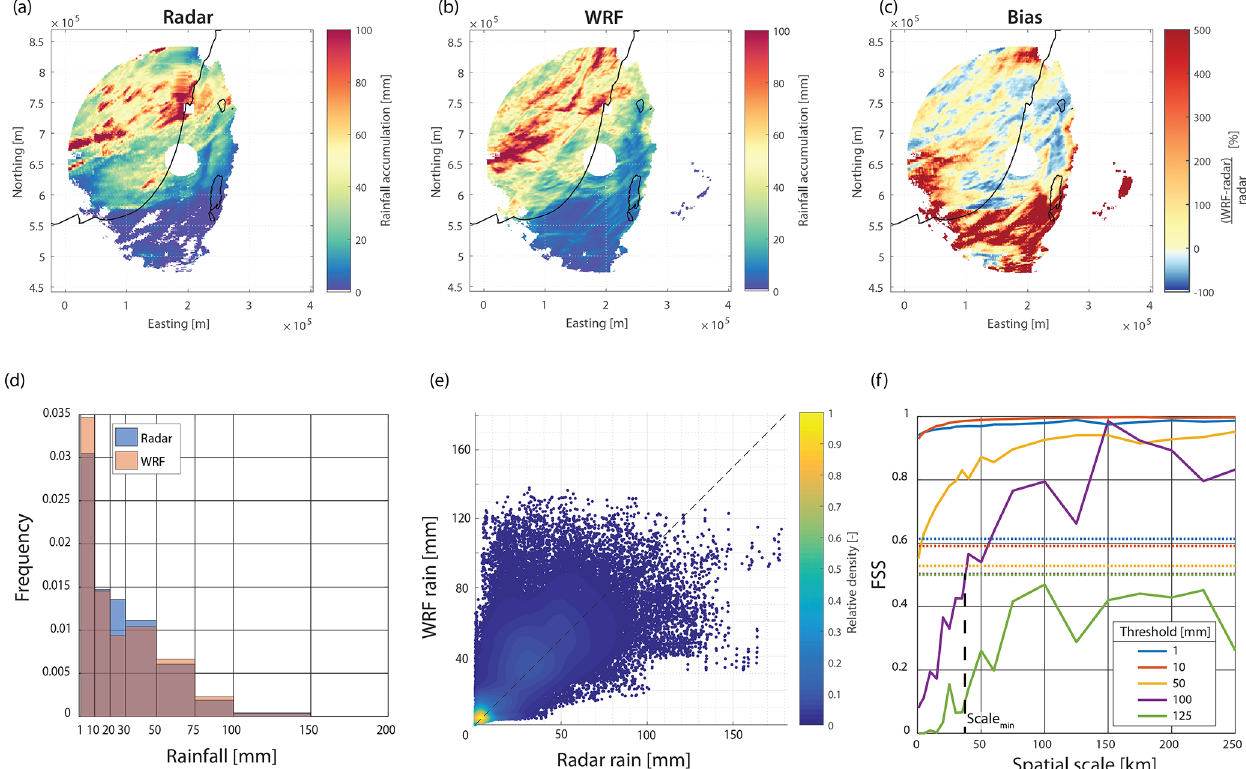
Figure 7. HPE 1 (09:00LT, 2 November 1991 to 09:00LT, 5 November 1991; all times in the figure are given in local winter time; see Table S1). Cumulative rainfall from (a) radar-derived QPE, (b) WRF-derived rainfall, and their ratio (c) . A pixel-based comparison between rainfall accumulations using a histogram ( d ; zero rainfall is omitted) and scatter plot (e) . Notice that although the rainfall distribution is quite well represented (d) , results of a single pixel might deviate substantially from the 1:1 line ( e ; dashed). The fractions skill score (FSS) for the same event for various cumulative rainfall thresholds is presented in panel (f) . Dashed lines are uniform FSSs for the same rainfall thresholds. The minimal scale for a valuable prediction for a 100mm rain depth (at the crossing of the FSS and the uniform FSS; see Sect. S1 in the Supplement for details) is also shown (dashed black line).